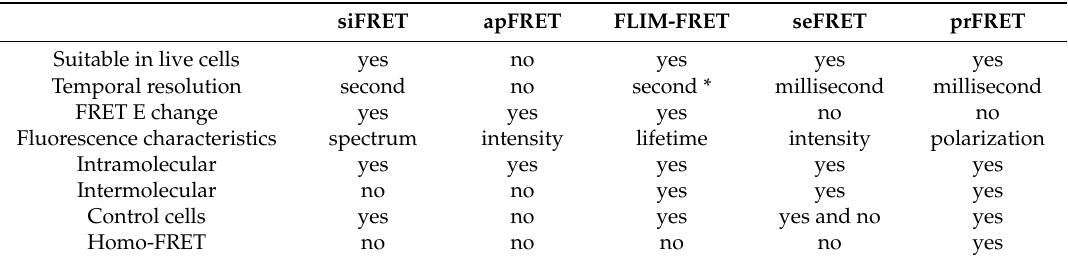
Table 1. Comparison of different FRET measurement methods. siFRET apFRET